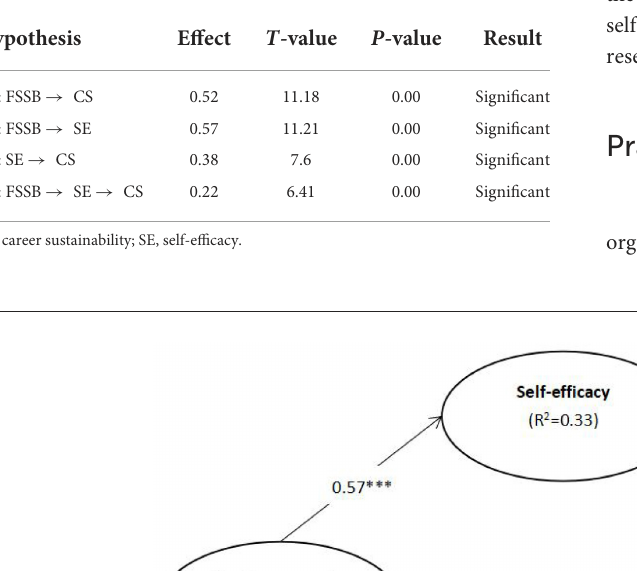
TABLE 4 Serial mediation results.